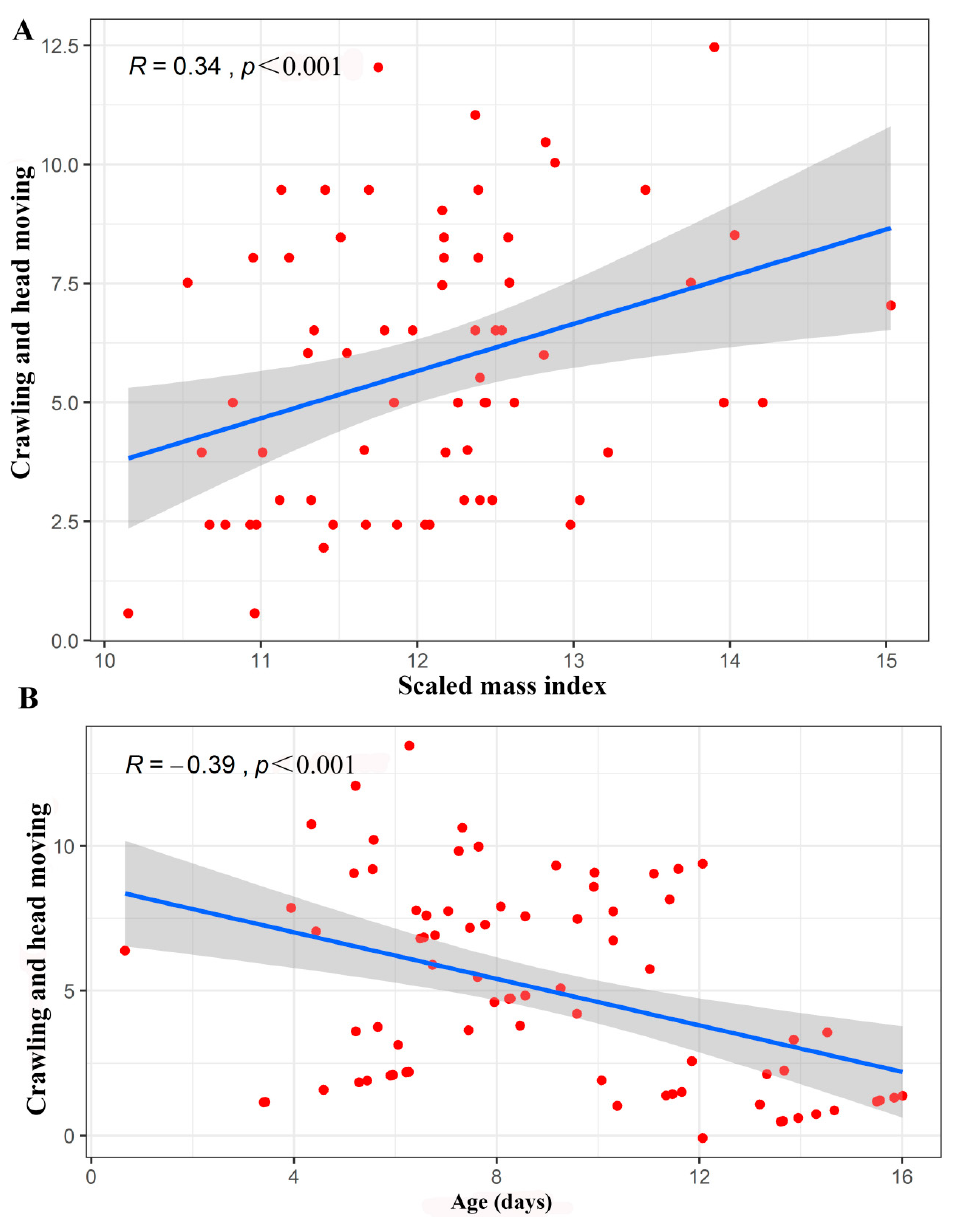
Figure 5. (A ) Scatter plot of the partial correlation between the scaled mass index and number of occurrences of the crawling and head moving behaviours in young Asian parti-coloured bats ( Vespertilio sinensis ). ( B ) Scatter plot of the partial correlation between age and number of occurrences of the crawling and head moving behaviours in young Asian parti-coloured bats ( Vespertilio sinensis ). The solid blue lines represent the fitted curves, and the shadowed areas represent the 95% confidence interval. The number of occurrences of the wing spreading and flapping behaviours was influenced by the scaled mass index ( Z = 4.16, p < 0.001), age ( Z = 4.27, p < 0.001), and the interaction between scaled mass index and age ( Z = 4.27, p < 0.001). Due to the significant interaction between age and scaled mass index, a partial correlation analysis was performed to control for the interaction between these two factors. When the age of the infants was controlled, there was a significant positive correlation between the scaled mass index and the wing spreading and flapping behaviours ( R = 0.47, p < 0.001). Furthermore, when the scaled mass index was controlled, there was a significant positive correlation between the age of the infants and the wing spreading and flapping behaviours ( R = 0.19, p = 0.03) (Figure 6).